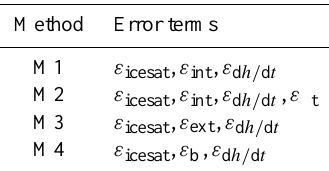
Table 1. The number of error terms present in each method. These error are then combined into a height error using RSS.